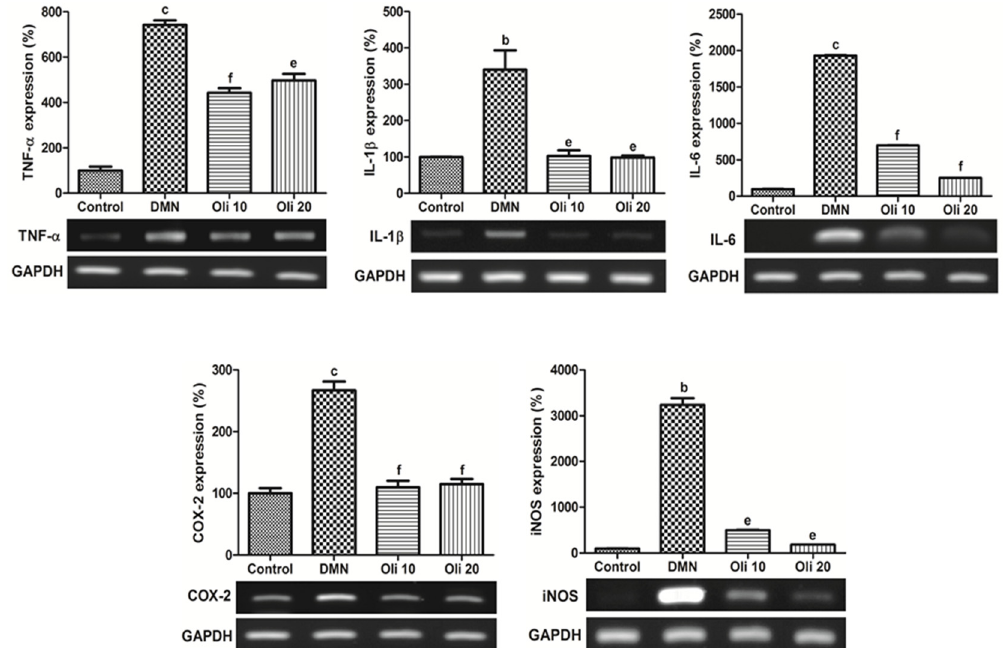
Figure 5. Effects of oligonol on the pro-inflammatory mediators. mRNA expression of TNF- α ( A ), IL-1 β ( B ), IL-6 ( C ), COX-2( D ), and iNOS ( E ) in rat liver intoxicated with DMN was assessed by RT-PCR. Values are mean ± SE ( n = 3). b p < 0.01 and c p < 0.001 vs. the control group, and e p < 0.01 and f p < 0.001 vs. the DMN group.